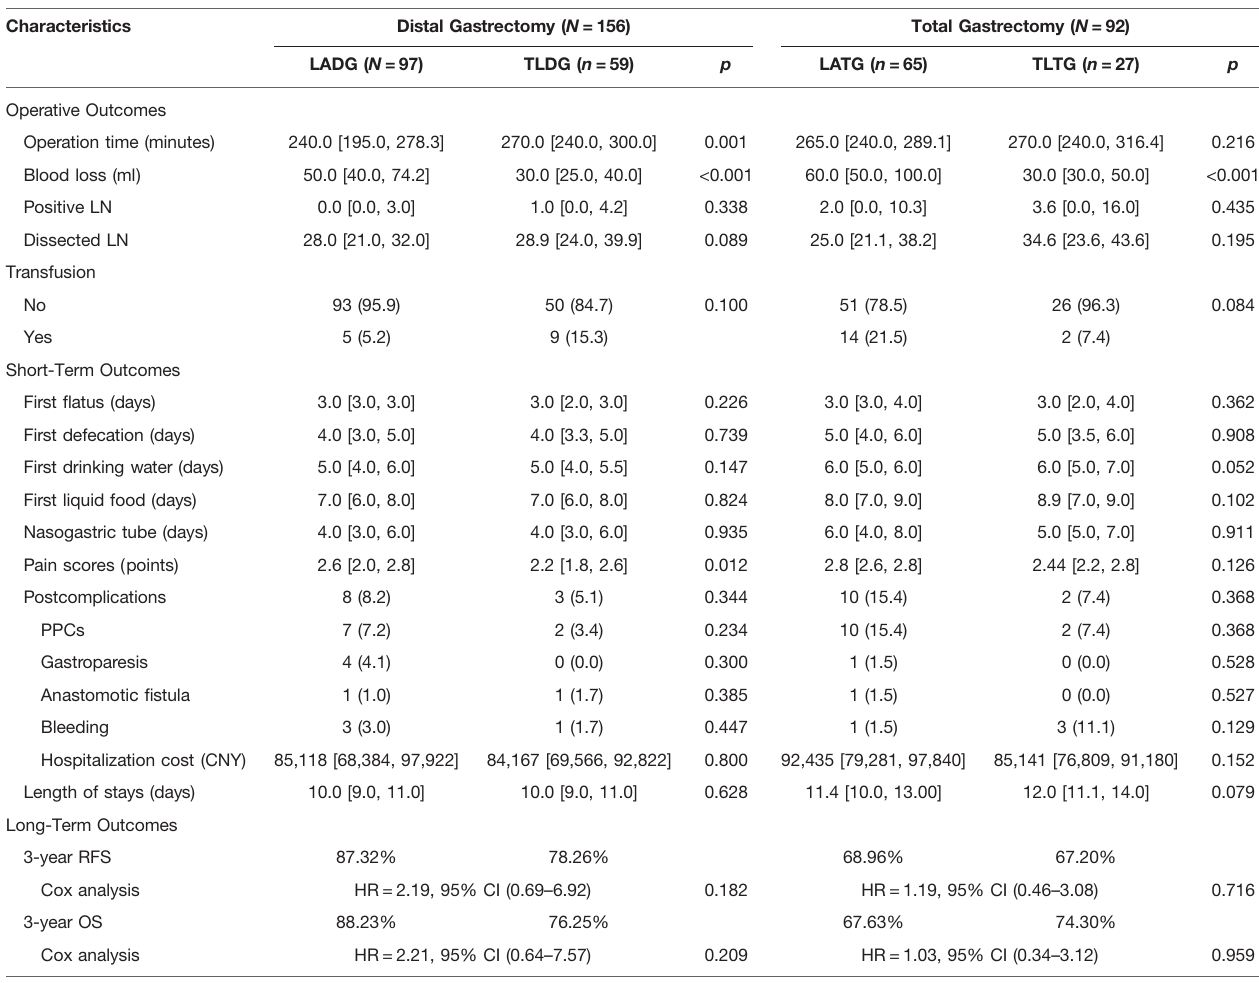
TABLE 5 | Subgroup analysis of operation methods after PS-IPTW.